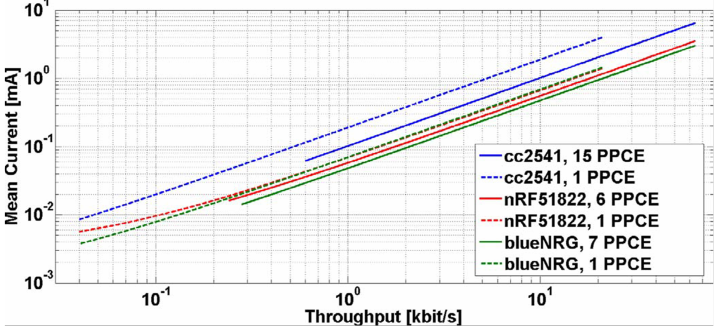
Figure 19. Current consumption as a function of throughput for different BLE ICs. This value is computed using the maximum and the minimum number of packets per connEvent (PPCE) each device may support. Adapted from